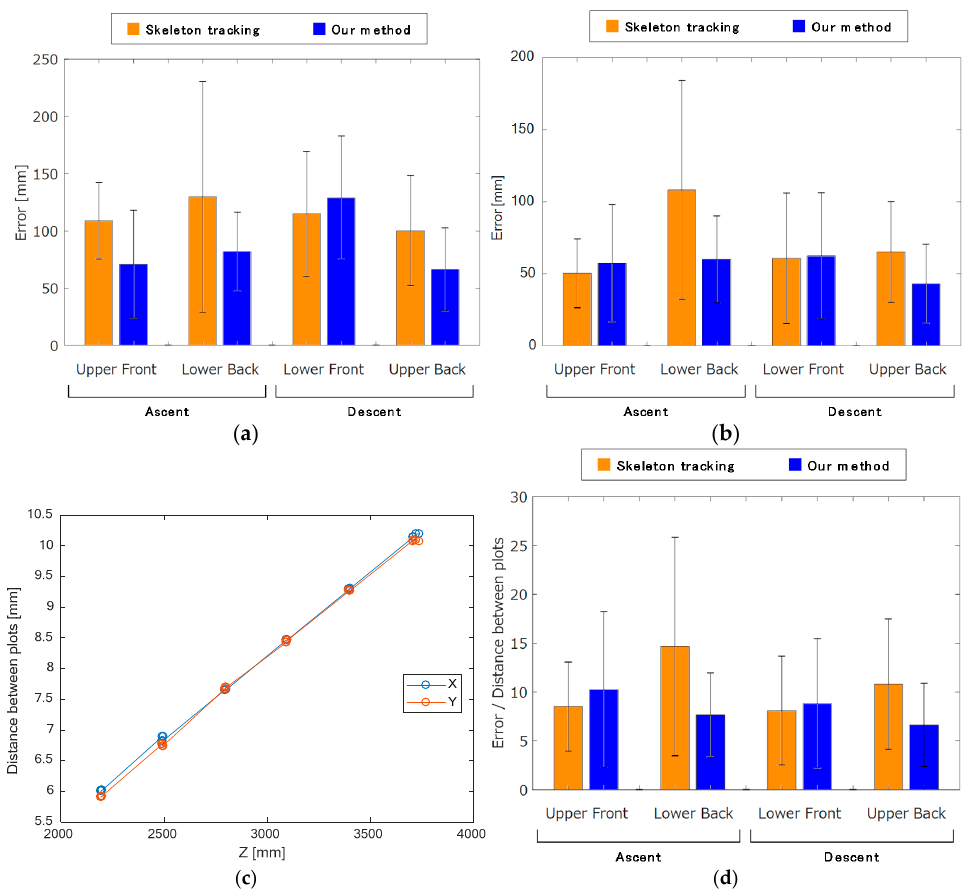
Figure 9. 3D error of our method compared with the Kinect skeleton tracking method: ( a ) unadjusted 3D error; ( b ) zero-mean shifted 3D error; ( c ) relation between resolution and distance from the Kinect sensor; ( d ) normalized 3D error. Data are shown as mean ± standard deviation.